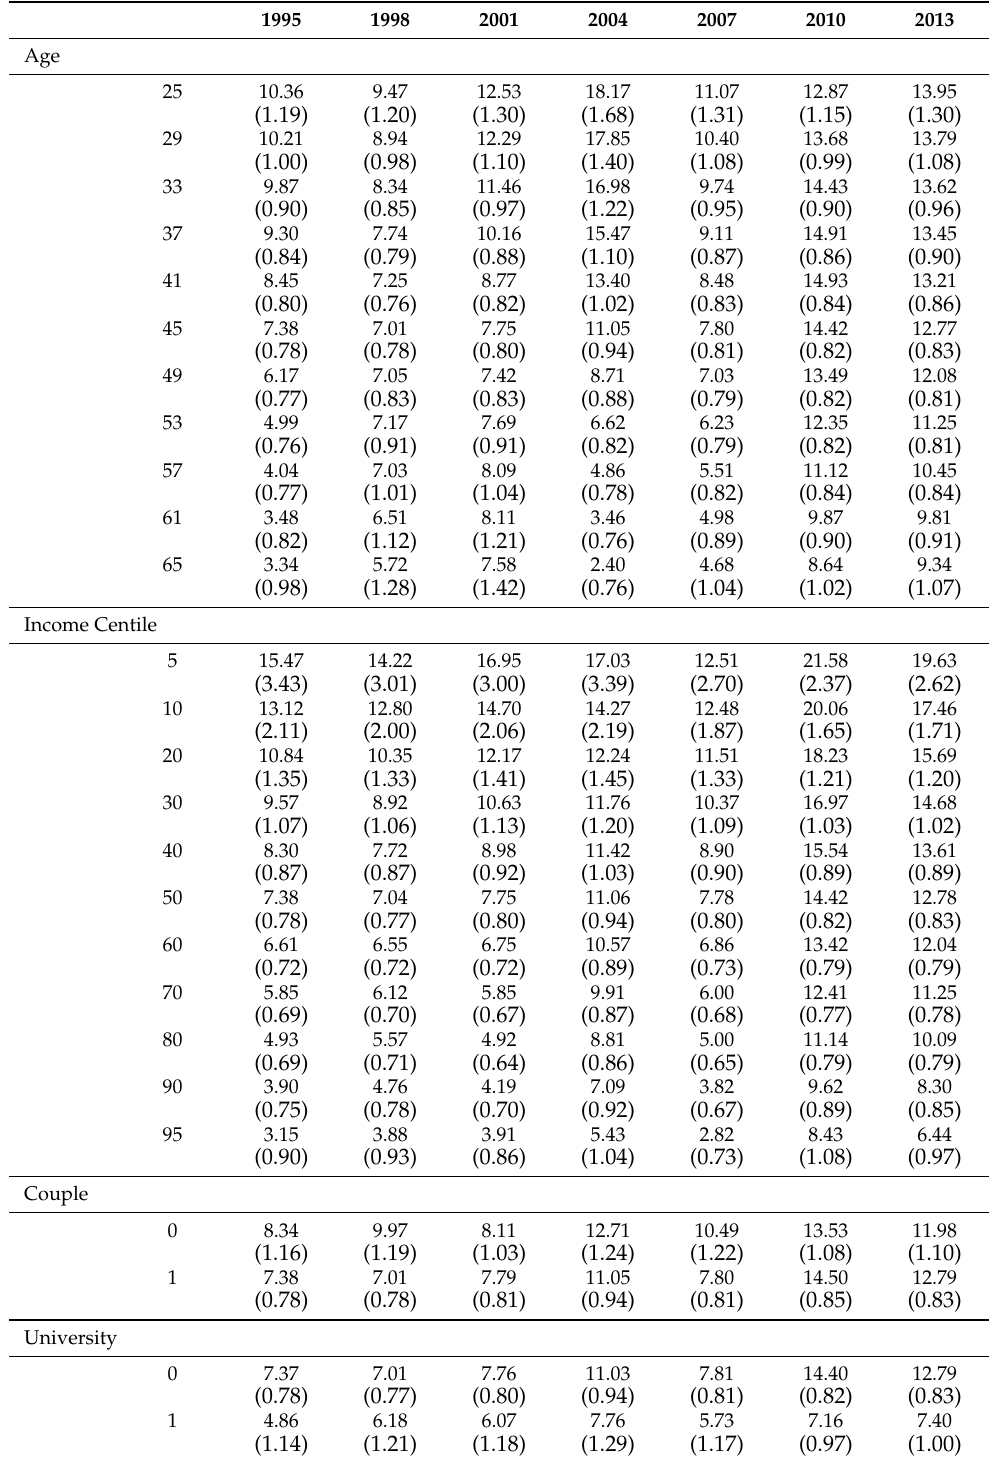
Table A8. Estimates of Arrears Among Borrowers for